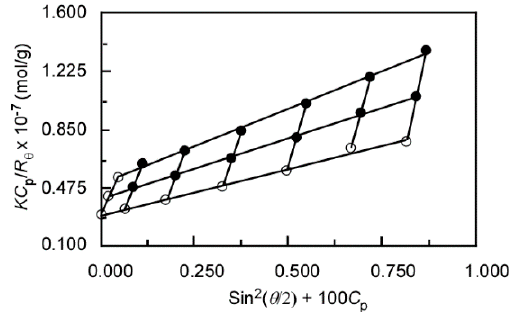
◦ 6 ) in water at 25